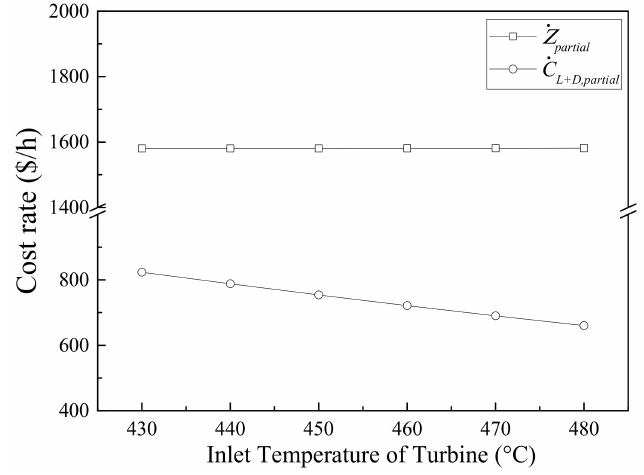
. . Z and C L + D with the partial-cooling cycle.